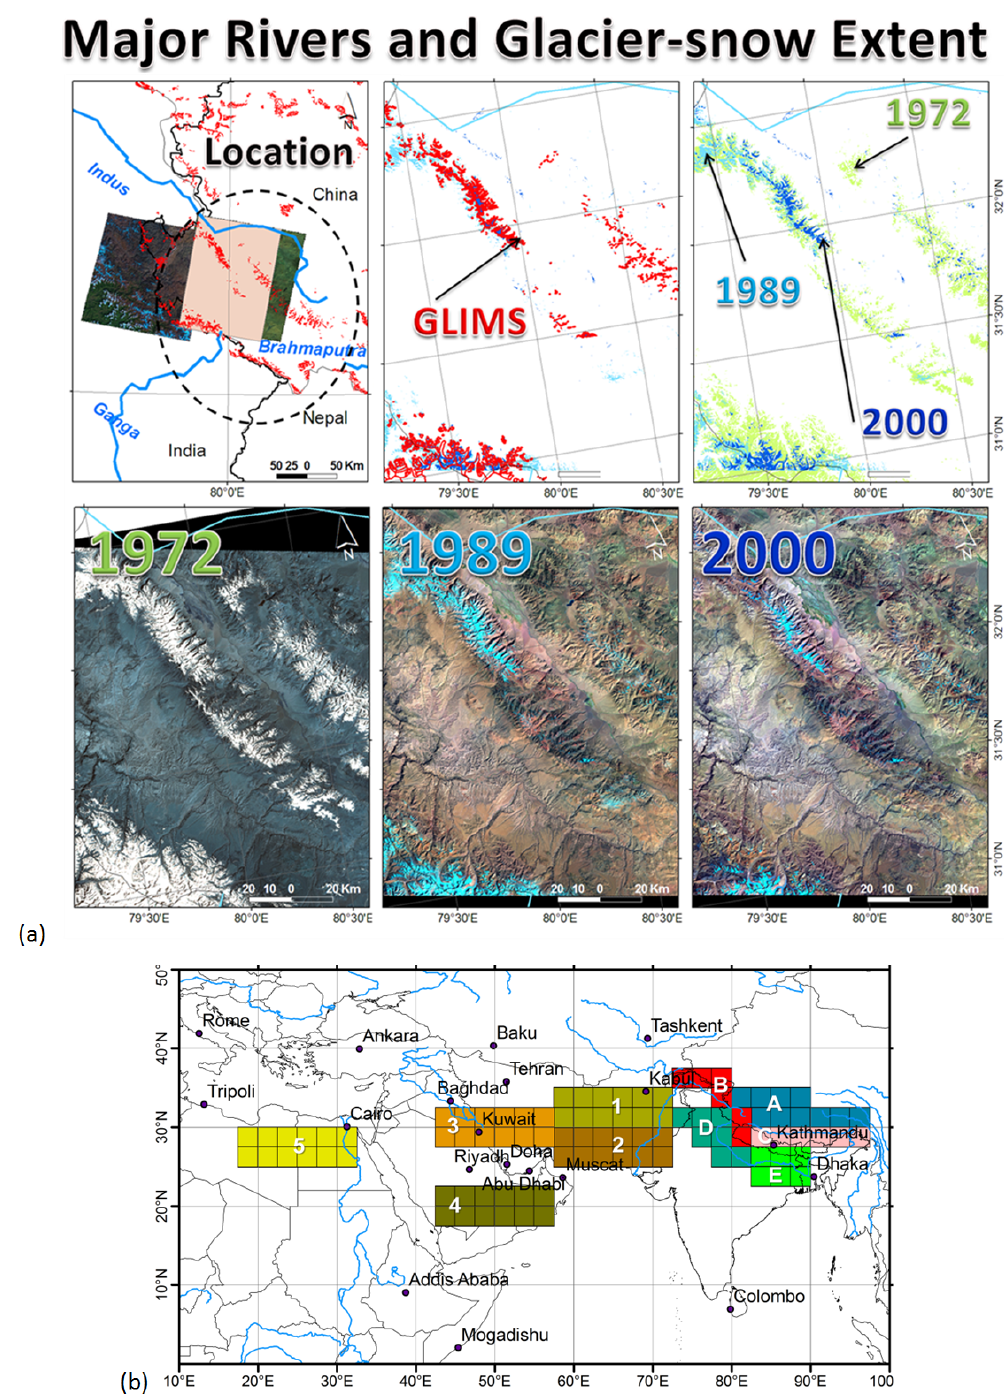
Fig. 1. (a) The upper panel show the major western Himalayan Glaciers area and the point of origin of major rivers of Asia, namely Indus, Ganga and Brahmaputra. The snow cover extent is shown in green (year 1972), light blue (year 1989) and deep blue (year 2000) as measured from Landsat and the Global Land Ice Measurements from Space (GLIMS) database (in red). The lower panel shows the extent of snow-glacier cover during years 1972, 1989 and 2000 over Gangotri glacier region (circled area, top panel). (b) Sub-division of study region into Tibetan region (code A), western Himalayas (code B), eastern Himalayas (code C), western IG plains (code D), eastern IG plains (code E). The major dust source regions of Asia-Africa affecting the IG plains and Himalayas are (1) Afghanistan-Pakistan region, (2) Iran-Pakistan-Thar desert region, (3) Middle East, (4) Arabian region, and (5) Sahara